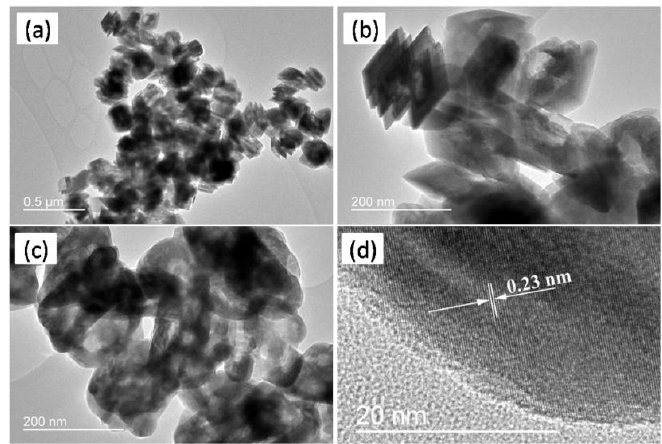
Figure 2. ( a ) Scanning transmission electron microscopy (STEM) image, ( b , c ) energy-dispersive X-ray spectroscopy (EDS) elemental mapping images and ( d ) EDS spectrum of Ga 2 O 3 .